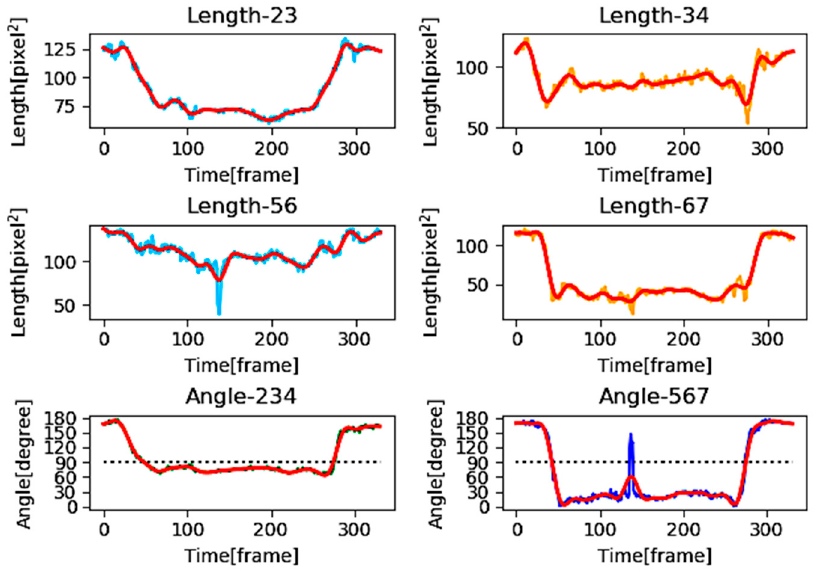
Figure 15. Sample P1 data after applying LPF.